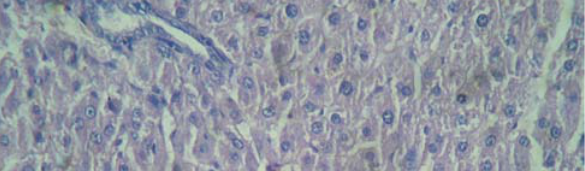
Fig 2. Photomicrograph showing centrilobular necrosis and ballooning degeneration (shown by arrow) of liver of paracetamol-treated control rats (×400)